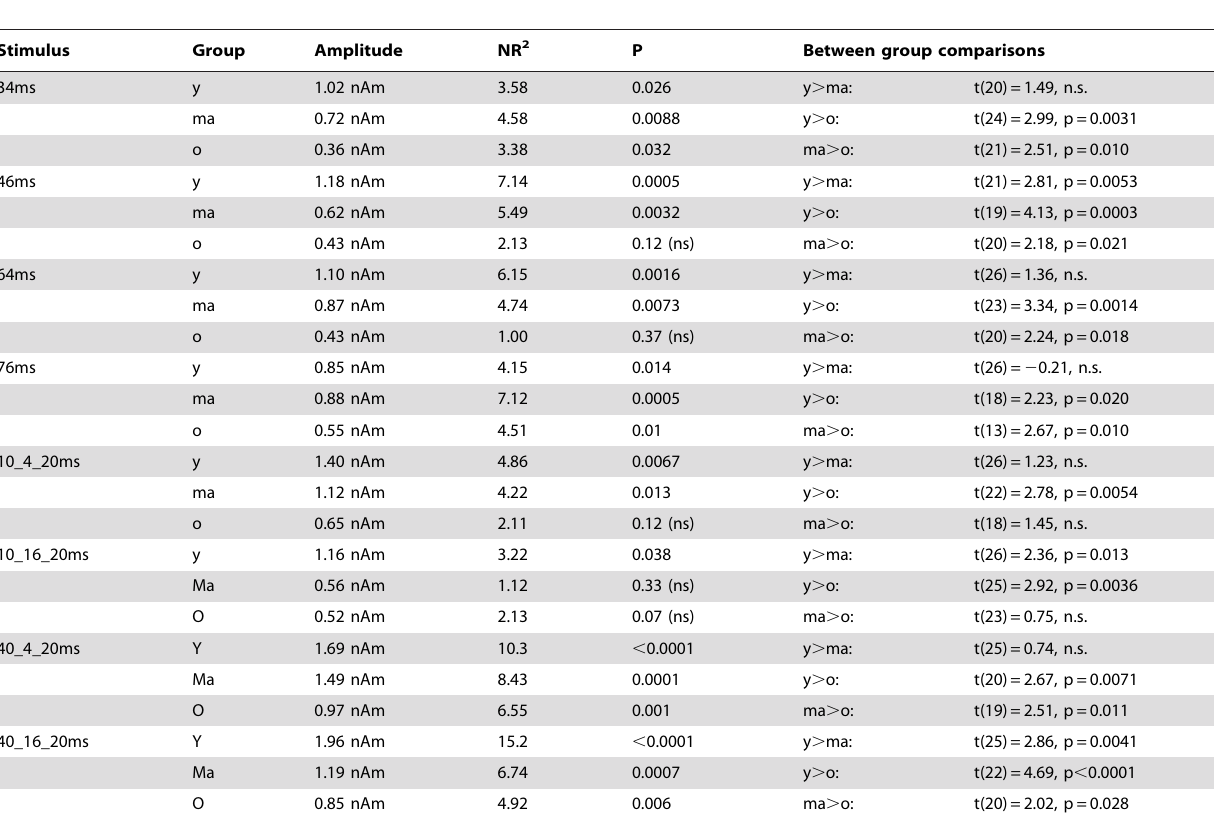
Table 1. Amplitudes of the high-gamma following the offset of the no-gap stimuli or the gap in the gap stimuli for the three age groups (y: young, ma: middle-aged, o: older), phase coherence nR 2 across the groups and p-value for the phase statistics, and results of t-tests for between group